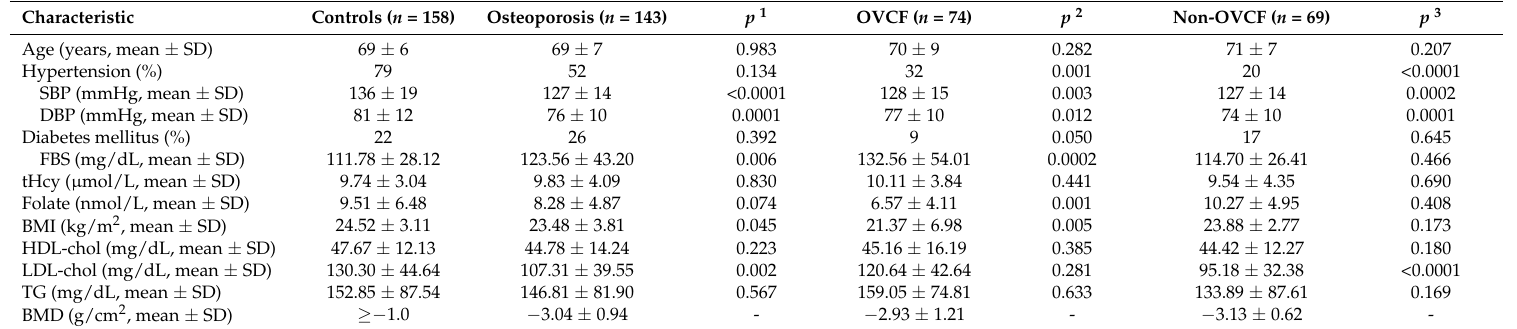
Table 1. Baseline characteristics between controls and osteoporosis patients.